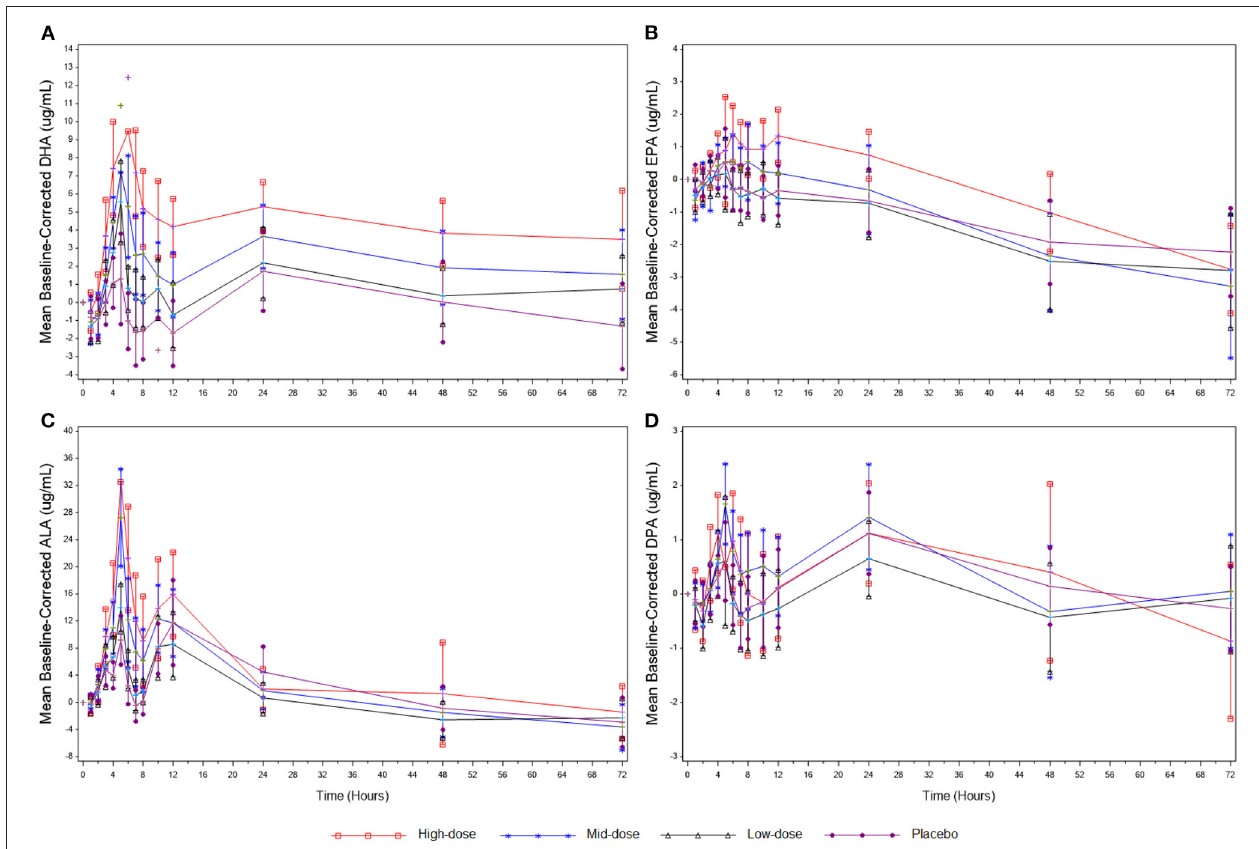
FIGURE 2 | (A) Mean baseline-corrected plasma concentrations of DHA during the 3-day PK phase. (B) Mean baseline-corrected plasma concentrations of EPA during the 3-day PK phase. (C) Mean baseline-corrected plasma concentrations of ALA during the 3-day PK phase. (D) Mean baseline-corrected plasma concentrations of DPA during the 3-day PK phase. Values are means ± SD. ALA, alpha-linolenic acid; DHA, docosahexaenoic acid; DPA, docosapentaenoic acid; EPA, eicosapentaenoic acid; PK,